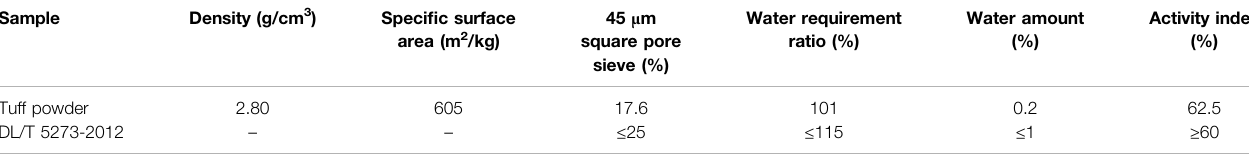
TABLE 2 | The physical properties of tuff